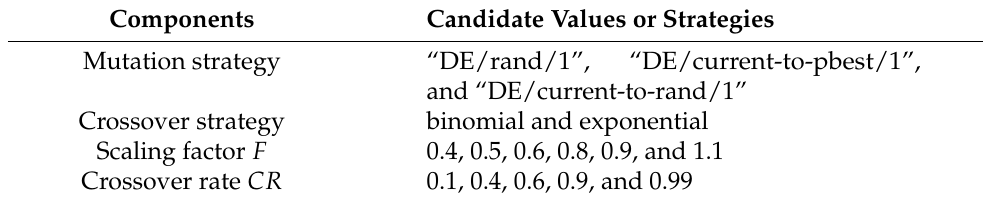
Figure 3. An example of the directed acyclic graph formed by key components of DE. Table 2. Candidate